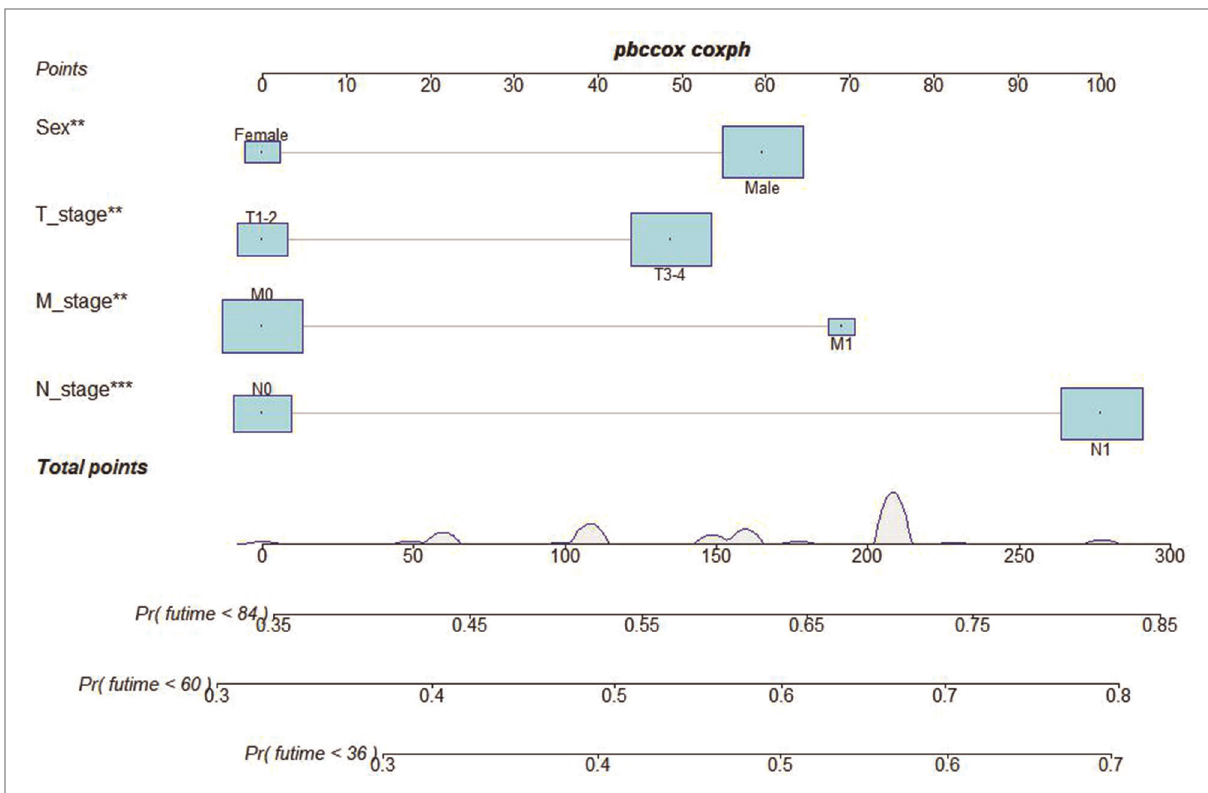
FIGURE 2 Nomogram model to predict the cancer-speci fi c survival (CSS) at 3-,5-, and 7- years in patients receiving neoadjuvant chemoradiotherapy.